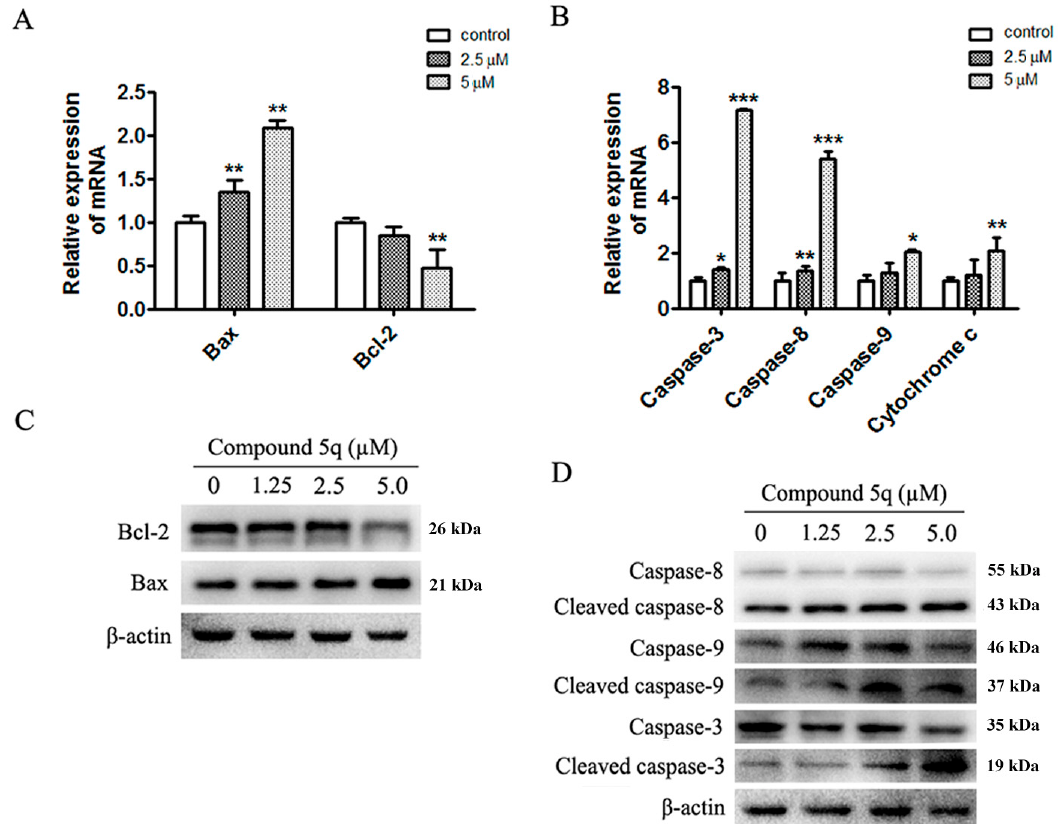
Figure 4. Effect of 5q on apoptosis regulators. ( A , B ) Real-time PCR analysis for Bax, Bcl-2, caspase-3, caspase-8, caspase-9 and cytochrome c in 5q -treated cells. Data were represented as mean ± SD (n = 3), * p < 0.05, ** p < 0.01, *** p < 0.001 as compared to control cells. ( C , D ) MG63 cells were treated with indicated concentrations of 5q for 24 h and protein levels of Bax, Bcl-2, caspases-3, 8, and 9 were analyzed by western blotting.